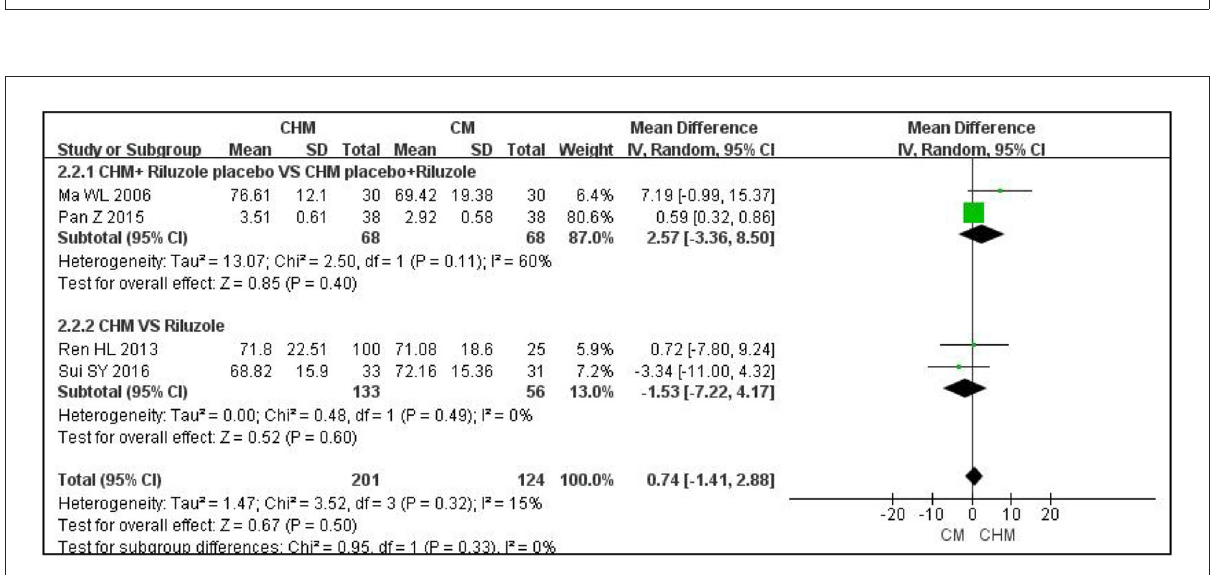
FIGURE2 Forest plot of m-Norris for ALS compared CHM with controls. m-Norris, modified Norris scales; CHM, Chinese herbal medicine; ALS, amyotrophic lateral sclerosis.